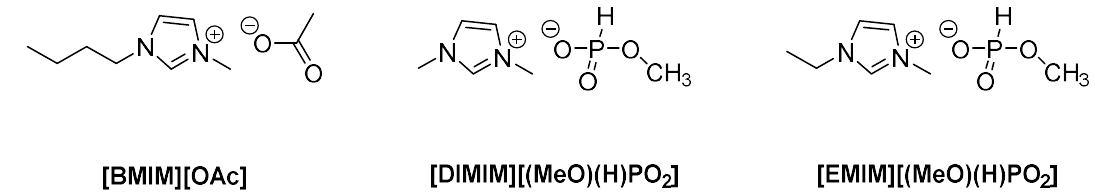
Figure 14. Chemical structures of the used ILs .